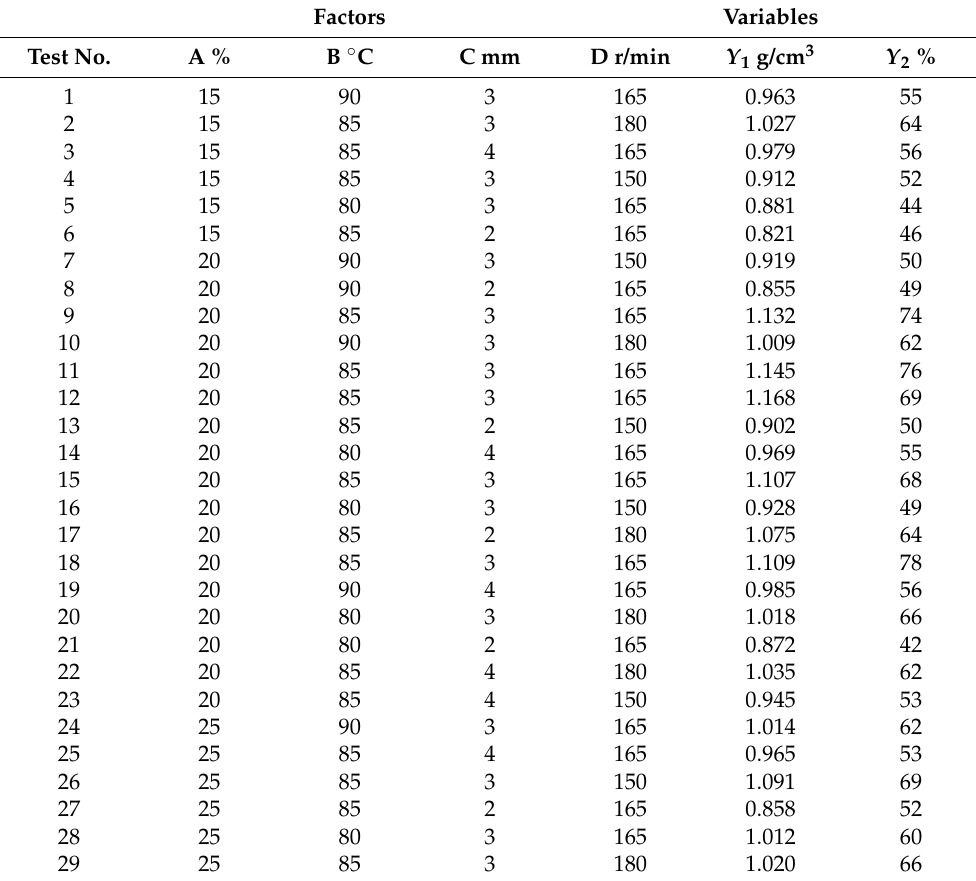
Table 3. Orthogonal testing program and